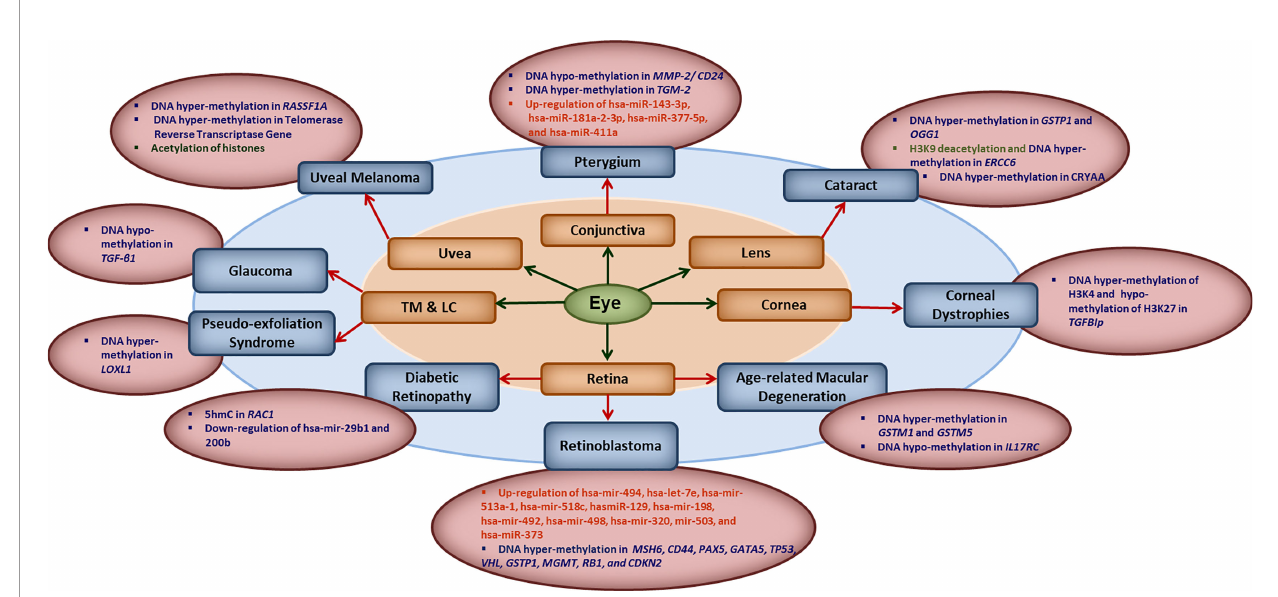
FIGURE 1 | Key epigenetic modi fi cations in common ocular diseases: Diverse epigenetic modi fi cations are associated with the common ocular diseases occurring in different parts of the eye. MMP2, matrix metalloproteinase 2; CD24, CD24 molecule; TGM2, transglutaminase 2; hsa-miR, human microRNA; GSTP1, pi-class glutathione-S-transferase; OGG1, 8-oxoguanine DNA glycosylase 1; ERCC6, excision repair 6 chromatin remodeling factor; CRYAA, crystalline Alpha-A; TGFBIp, transforming growth factor b - induced; GSTM1/5, glutathione S-transferase isoform mu1/mu5; IL17RC, interleukin-17 receptor C; MSH6, mutS homolog 6; CD44, cluster of differentiation 44; PAX5, paired box 5; GATA5, GATA binding protein 5; TP53, tumor protein 53; VHL, Von Hippel-Lindau gene; GSTP1, glutathione S- transferase pi-1; MGMT, methylguanine methyltransferase; RB1, retinoblastoma 1; CDKN2, cyclin-dependent kinase inhibitor 2; 5hmC, 5-hydroxymethyl cytosine; RAC1, rac family small GTPase 1; LOXL1, lysyl oxidase-like 1; TGF- b 1, transforming growth factor- b 1; RASSF1A, RAS association domain family 1A gene; TM, trabecular meshwork; LC, the lamina